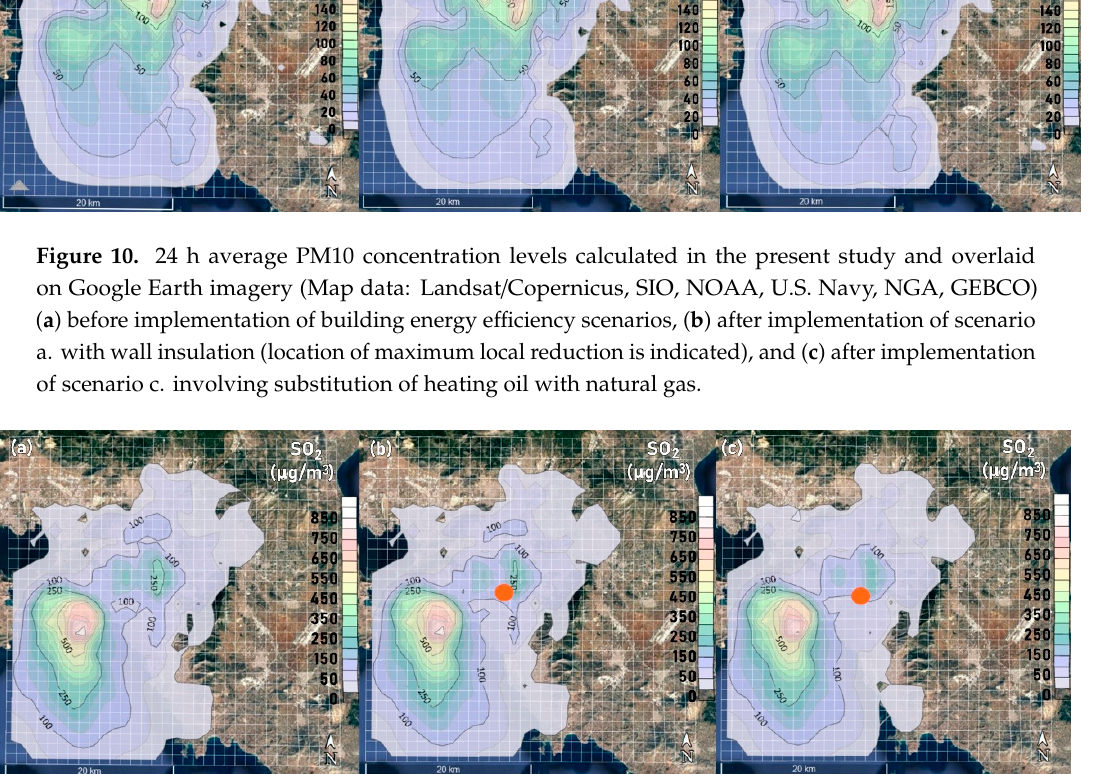
Figure 11. 1 h average SO 2 concentration levels calculated in the present study and overlaid on Google Earth imagery (Map data: Landsat/Copernicus, SIO, NOAA, U.S. Navy, NGA, GEBCO) ( a ) before implementation of building energy efficiency scenarios, ( b ) after implementation of scenario a. with wall insulation (location of maximum local reduction is indicated), and ( c ) after implementation of scenario c. involving substitution of heating oil with natural gas (location of maximum local reduction is indicated).